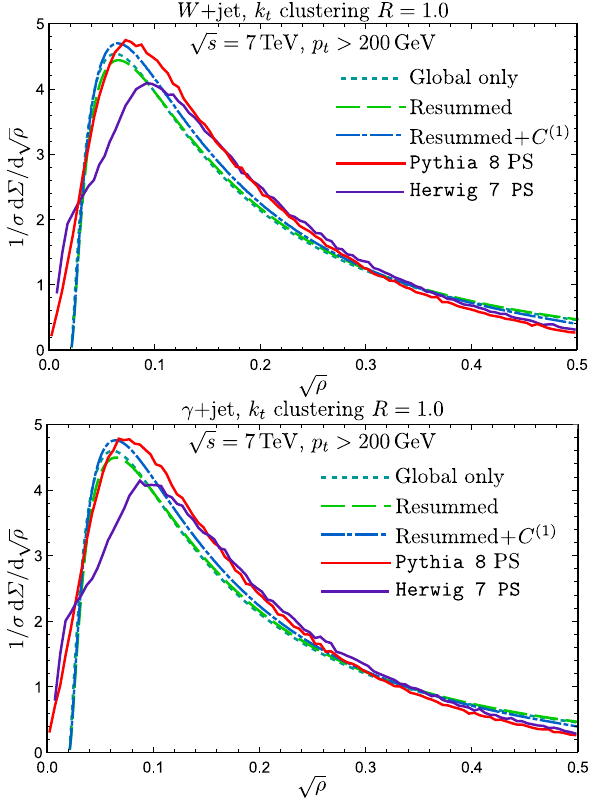
Fig. 12 Resummed differential jet mass distribution with k t cluster- ing compared to Pythia 8 and Herwig 7 PS for R = 1 . 0 in the processes W + jet and γ + jet at the LHC